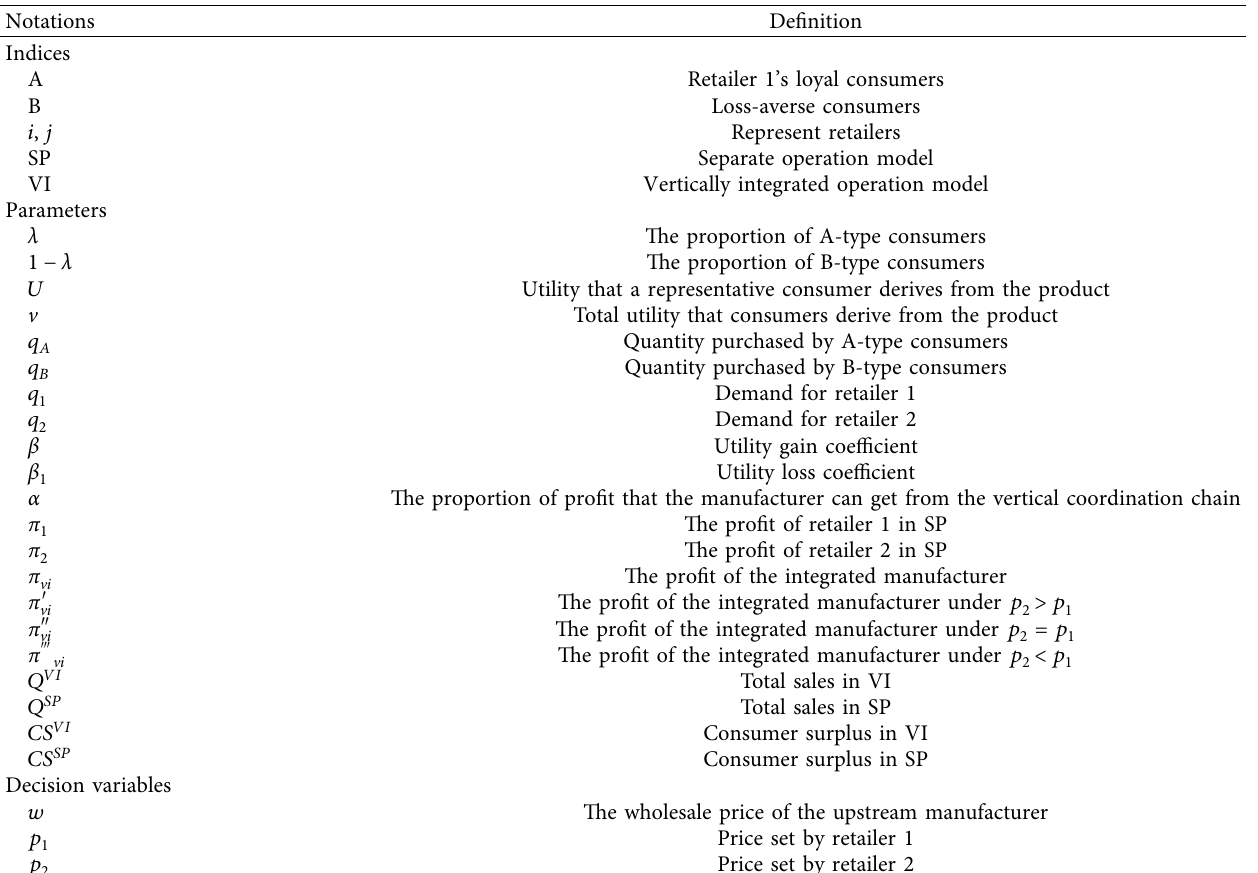
Figure 3: Diagram of the model structure. Table 2: Summary of